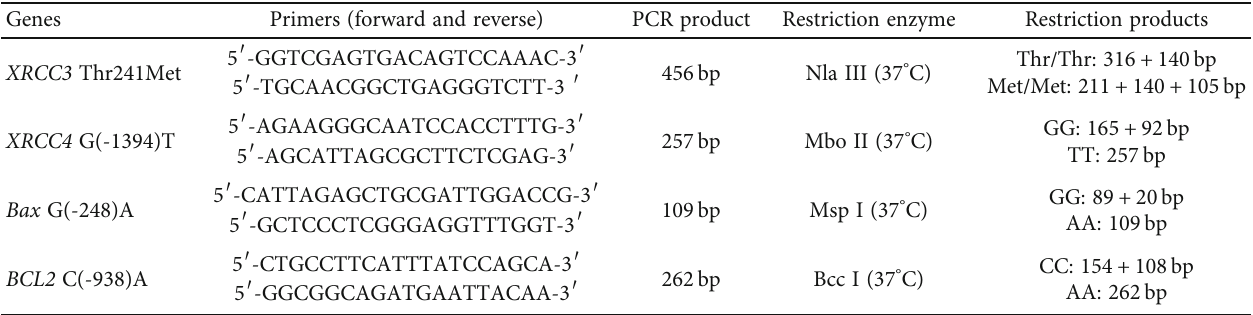
Table 3: PCR and RFLP procedures and expected products of XRCC3 Thr241Met, XRCC4 G( ‐ 1394) T, Bax G(-248) A, and BCL2 C( – 938) A genes.